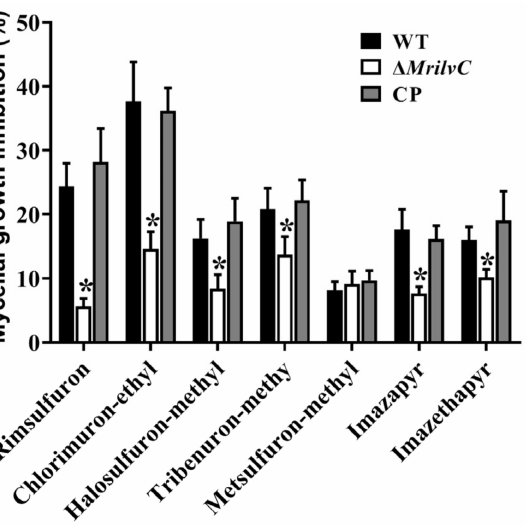
Figure 3. The MrILVC deletion mutant is resistant to AHAS inhibitors. Error bars represent the SEM of six replicate assays. * Significantly different expression with respect to the WT standard ( p <